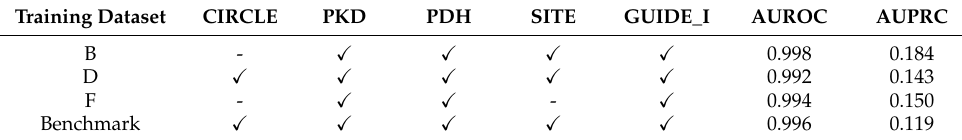
Table 5. Performance of R-CRISPR with different training datasets on Datasets GUIDE_III.